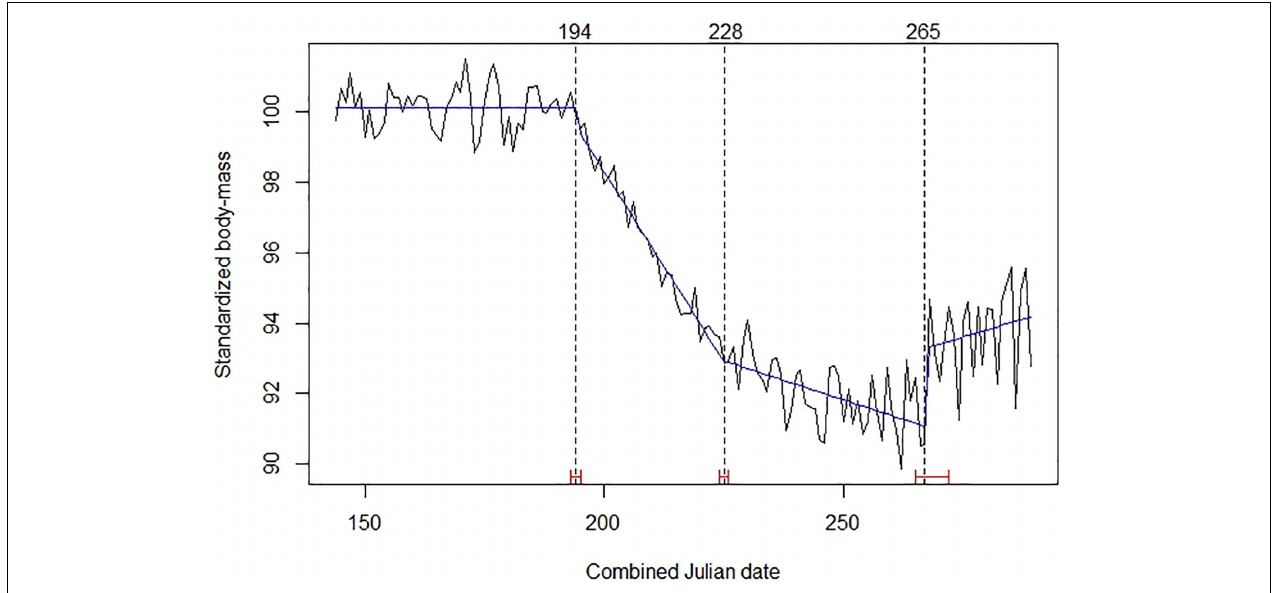
FIGURE 1 | Mean daily standardized body mass of roe deer (black broken line), trends (blue line), Julian date of estimated structural changes (dashed lines, labeled at the top), and 95% confidence intervals of estimated structural change date (red bars). Table 1 provides details about sample size and origin of data.